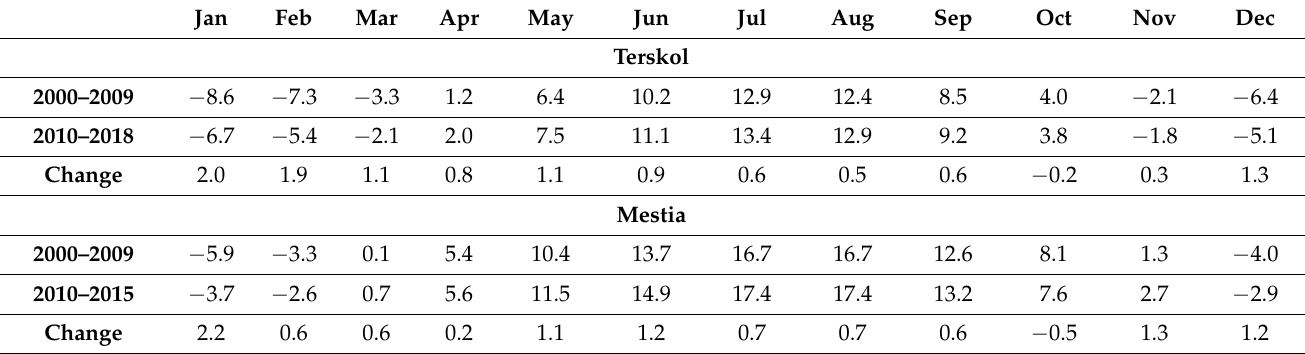
Table 1. Mean monthly air temperatures ( ◦ C) for the Terskol and Mestia meteorological stations.